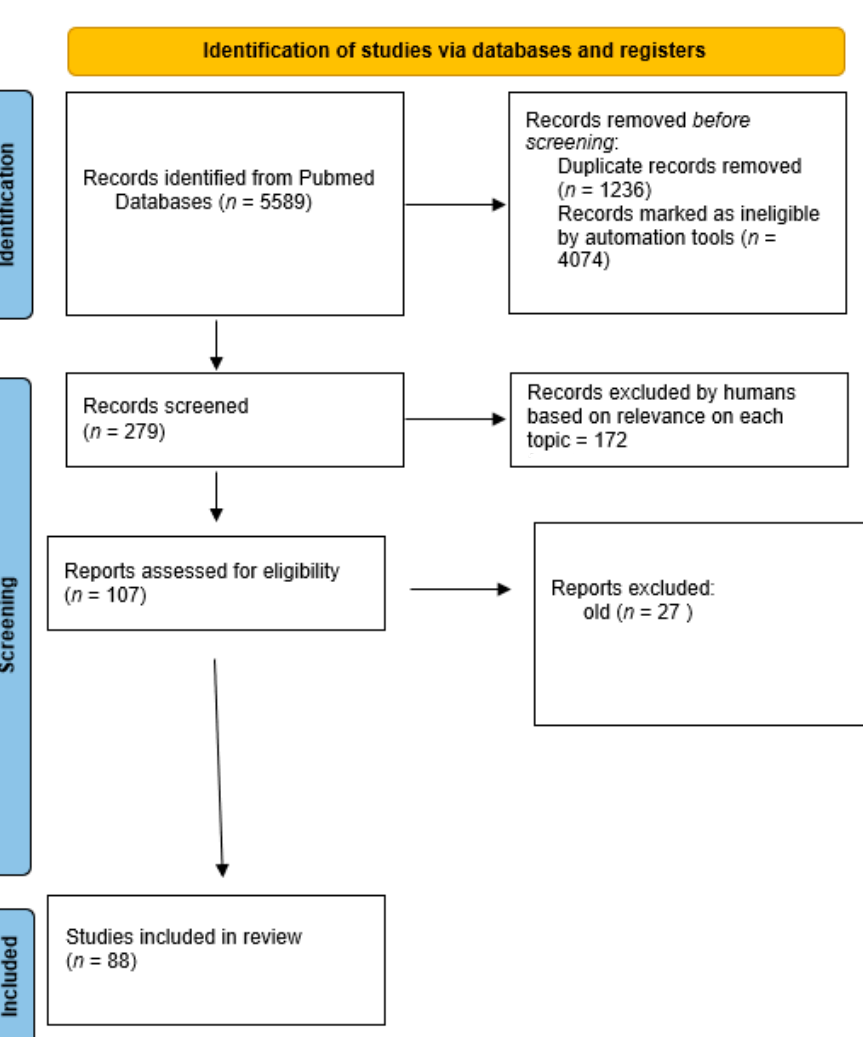
Figure 6. Flow diagram regarding paper selection process using Prisma 2020 statement [95].